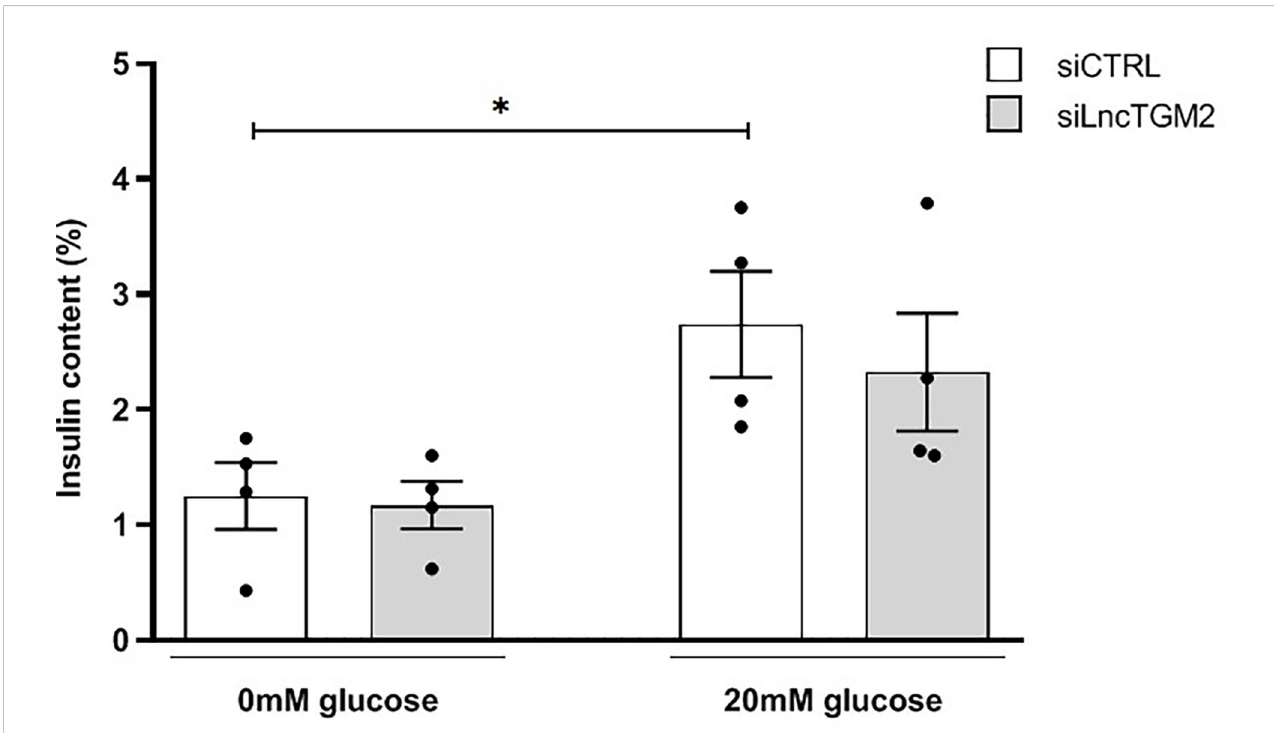
FIGURE 4 LncTGM2 downregulation affects glucose-stimulated insulin secretion. LncTGM2 was silenced using a siRNA and EndoC- b H1 cells were exposed to 0 or 20 mmol/l glucose. Insulin release was determined by ELISA. The results are means ± S.E.M. of 4 independent experiments; *p<0.05 by Student ’ s